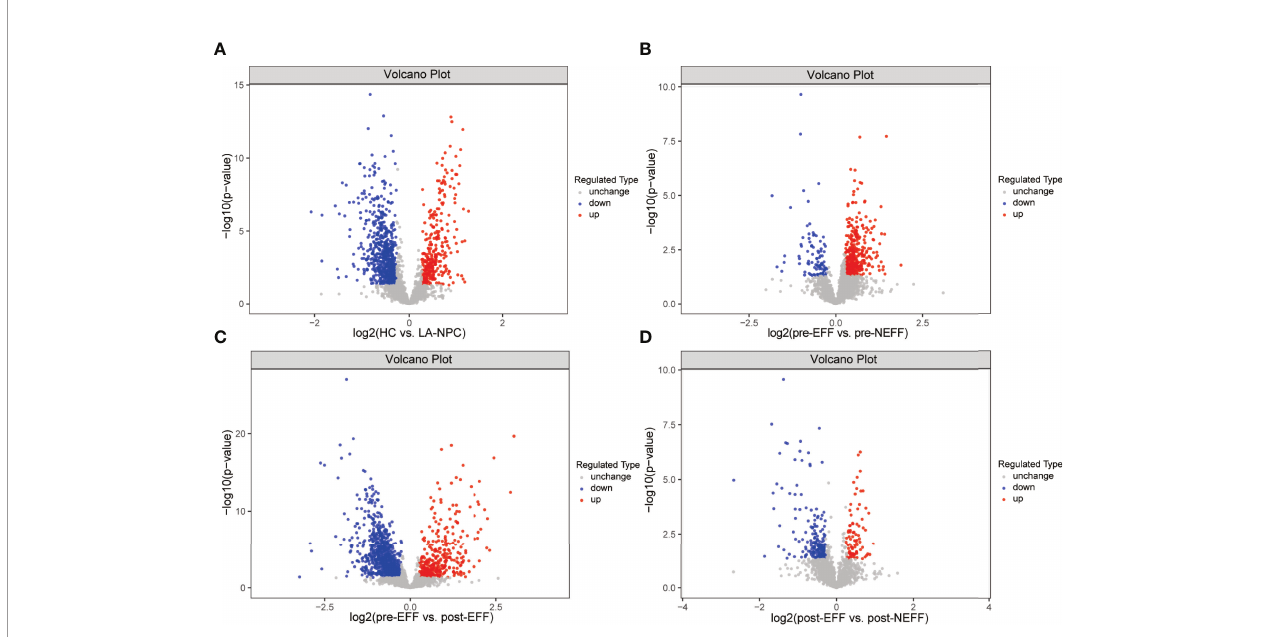
FIGURE 3 | Volcano map of differentially expressed proteins (DEPs). Red represents upregulated DEPs and blue represents downregulated DEPs. (A) DEPs between HC and LA-NPC groups. (B) DEPs between pre-EFF and pre-NEFF groups. (C) DEPs between pre-EFF and post-EFF groups. (D) DEPs between post-EFF and post- NEFF